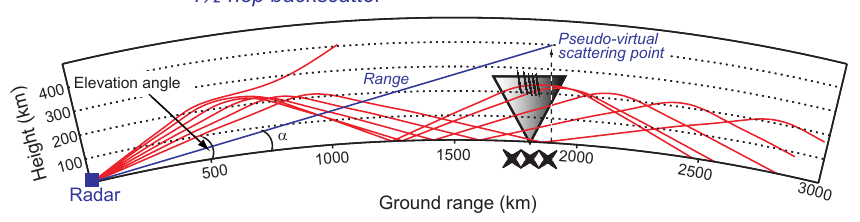
-hop HF radar propagation paths to the ionosphere above the Tromsø and SPEAR heating facilities. Fig. 2. A schematic of 1 1 2